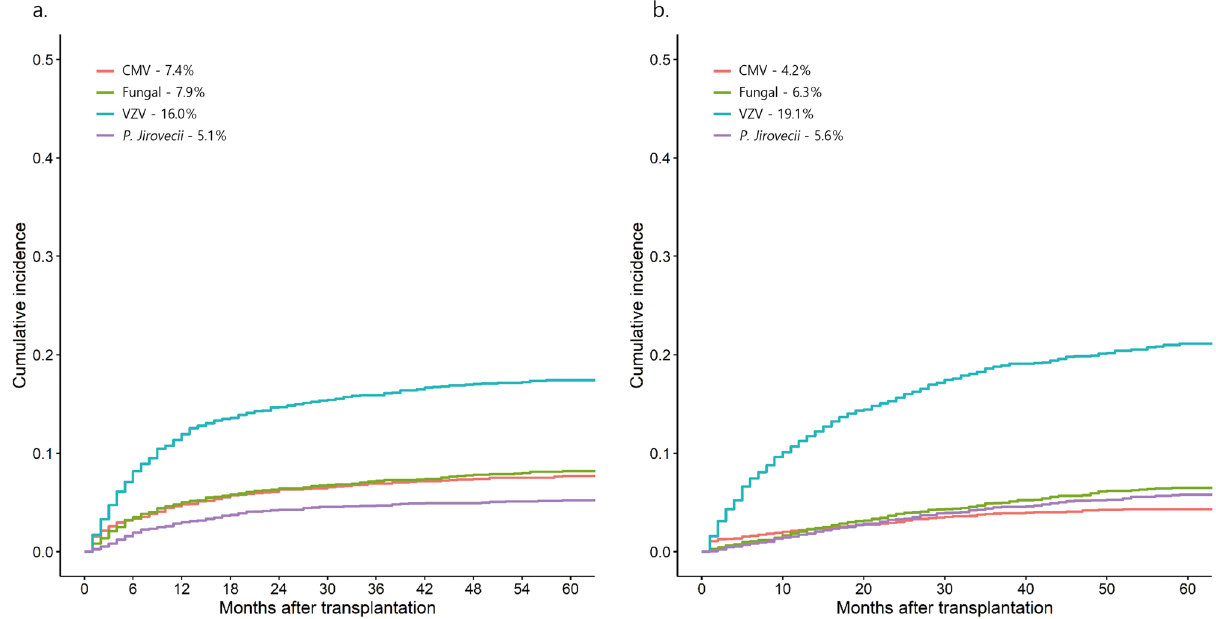
Figure 1. Cumulative incidence rates (CIRs) of opportunistic infections. ( A ) Lymphoma. ( B ) Multiple myeloma. ( A ) The CIRs at 6 months of fungal, Varicella zoster virus (VZV), Cytomegalovirus (CMV), and Pneumocystis jirovecii ( P. jiroveciii) infection was 3.4%, 7.8%, 3.3% and 1.9%, respectively. The CIRs at 12 months was 4.9%, 11.3%, 4.7% and 2.9%. ( B ) The CIRs at 6 months of fungal, VZV, CMV, and P. jiroveciii infection was 1.1%, 7.2%, 1.6% and 0.8%, respectively. The CIRs at 12 months was 2.0%, 10.6%, 2.2% and